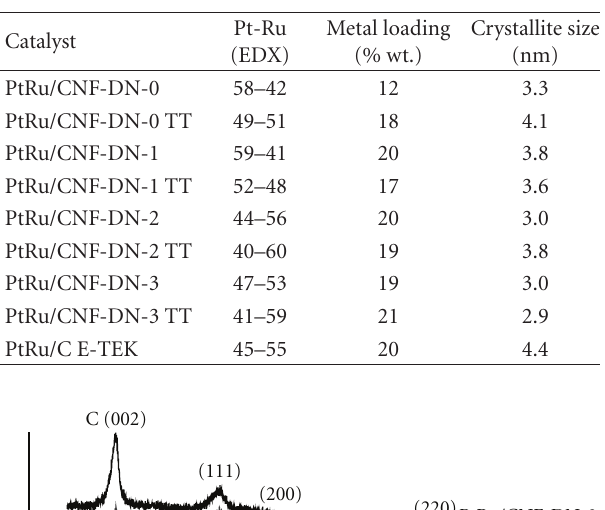
Table 1: Composition and crystallite sizes for Pt-Ru catalysts.